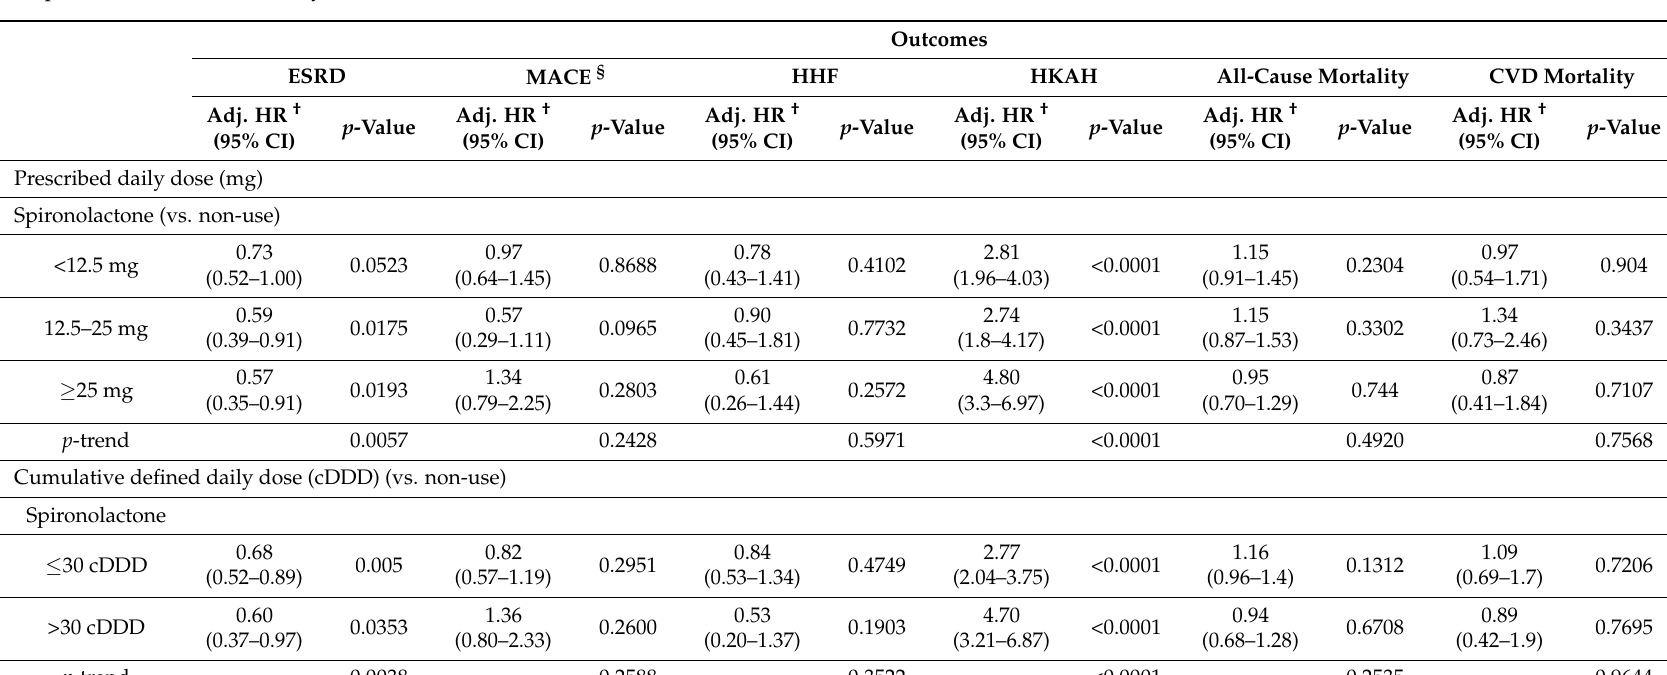
Table 3. Risks for ESRD, MACEs, HHF, HKAH and mortality among patients with stage 3–4 CKD by prescribed daily dose and cumulative defined daily dose of spironolactone within 90